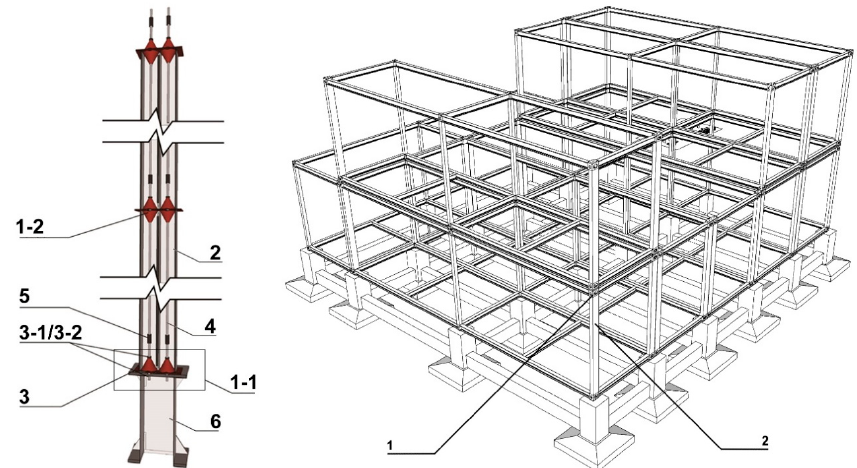
Figure 3. Structural module “pin” connection method. 1: lifting lug, 1-1: end lifting lug, 1-2: middle